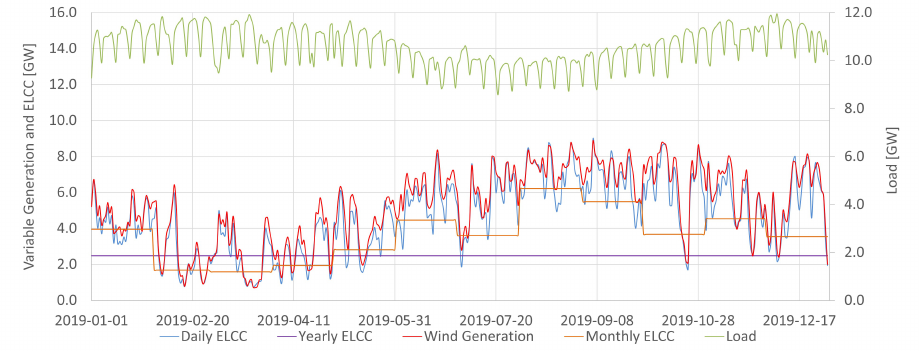
Figure 13. Daily, monthly and yearly ELCC for wind power in 2018 for the Northeast subsystem.